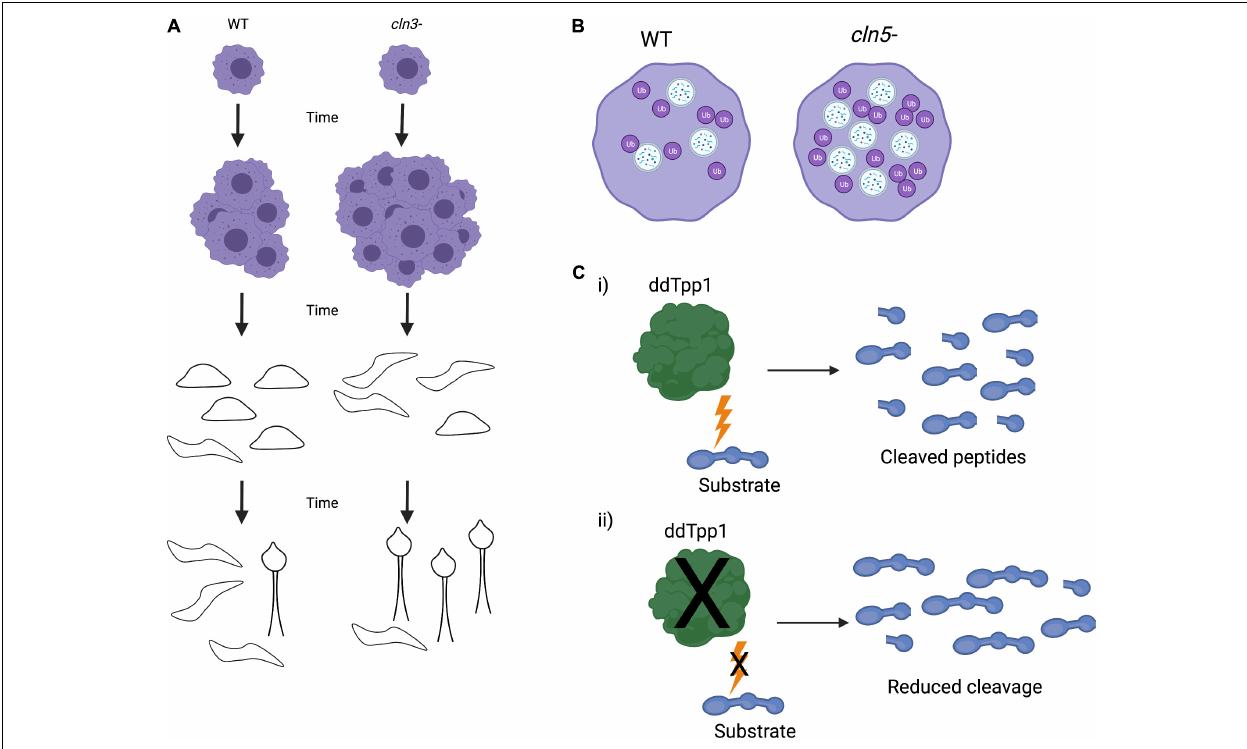
FIGURE 4 | Dictyostelium phenotypes of Cln knockout strains. (A) Knockout of Cln3 ( cln3 − ) in Dictyostelium leads to an increase in vegetative growth as well as faster slug formation, migration, and fruiting body formation. (B) Cln5 knockout ( cln5 − ) results in an increase in autophagosome formation and ubiquitination of proteins, indicating upregulated autophagic activity. (C) Dictyostelium ddTpp1 normally cleaves a synthetic human substrate of human TPP1 (i) , but in tpp1 - cells, cleavage of the substrate is greatly reduced (ii)